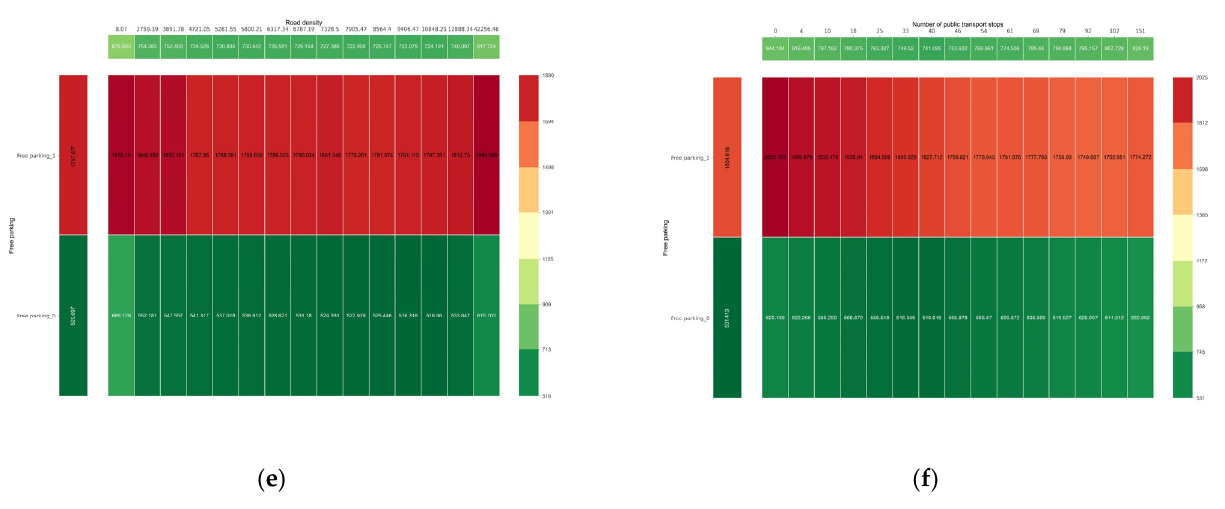
Figure 8. Synergistic effects of free parking and other built environment elements. ( a ) Synergy of land intensity and free parking; ( b ) Synergy of land use entropy and free parking; ( c ) Synergy of population density and free parking; ( d ) Synergy of the distance to the city center and free parking; ( e ) Synergy of road density and free parking; ( f ) Synergy of the distance to the nearest public transit station and free parking.